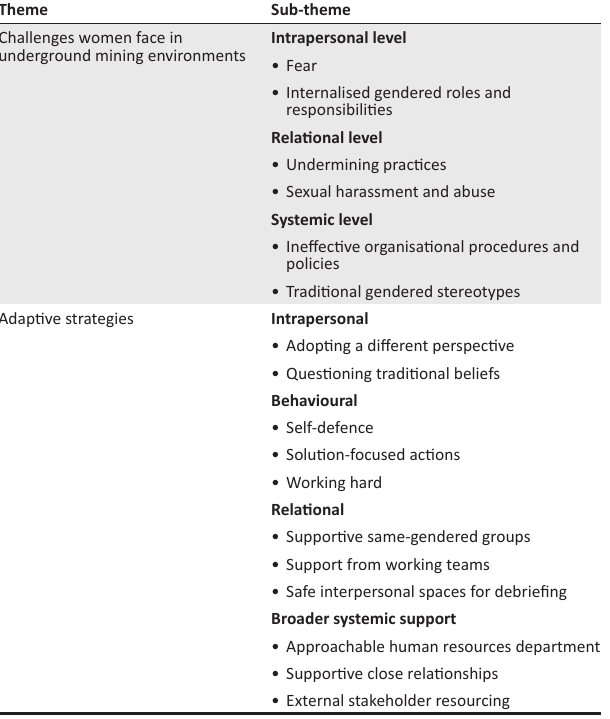
TABLE 1: Challenges and adaptive strategies of women in an underground mining